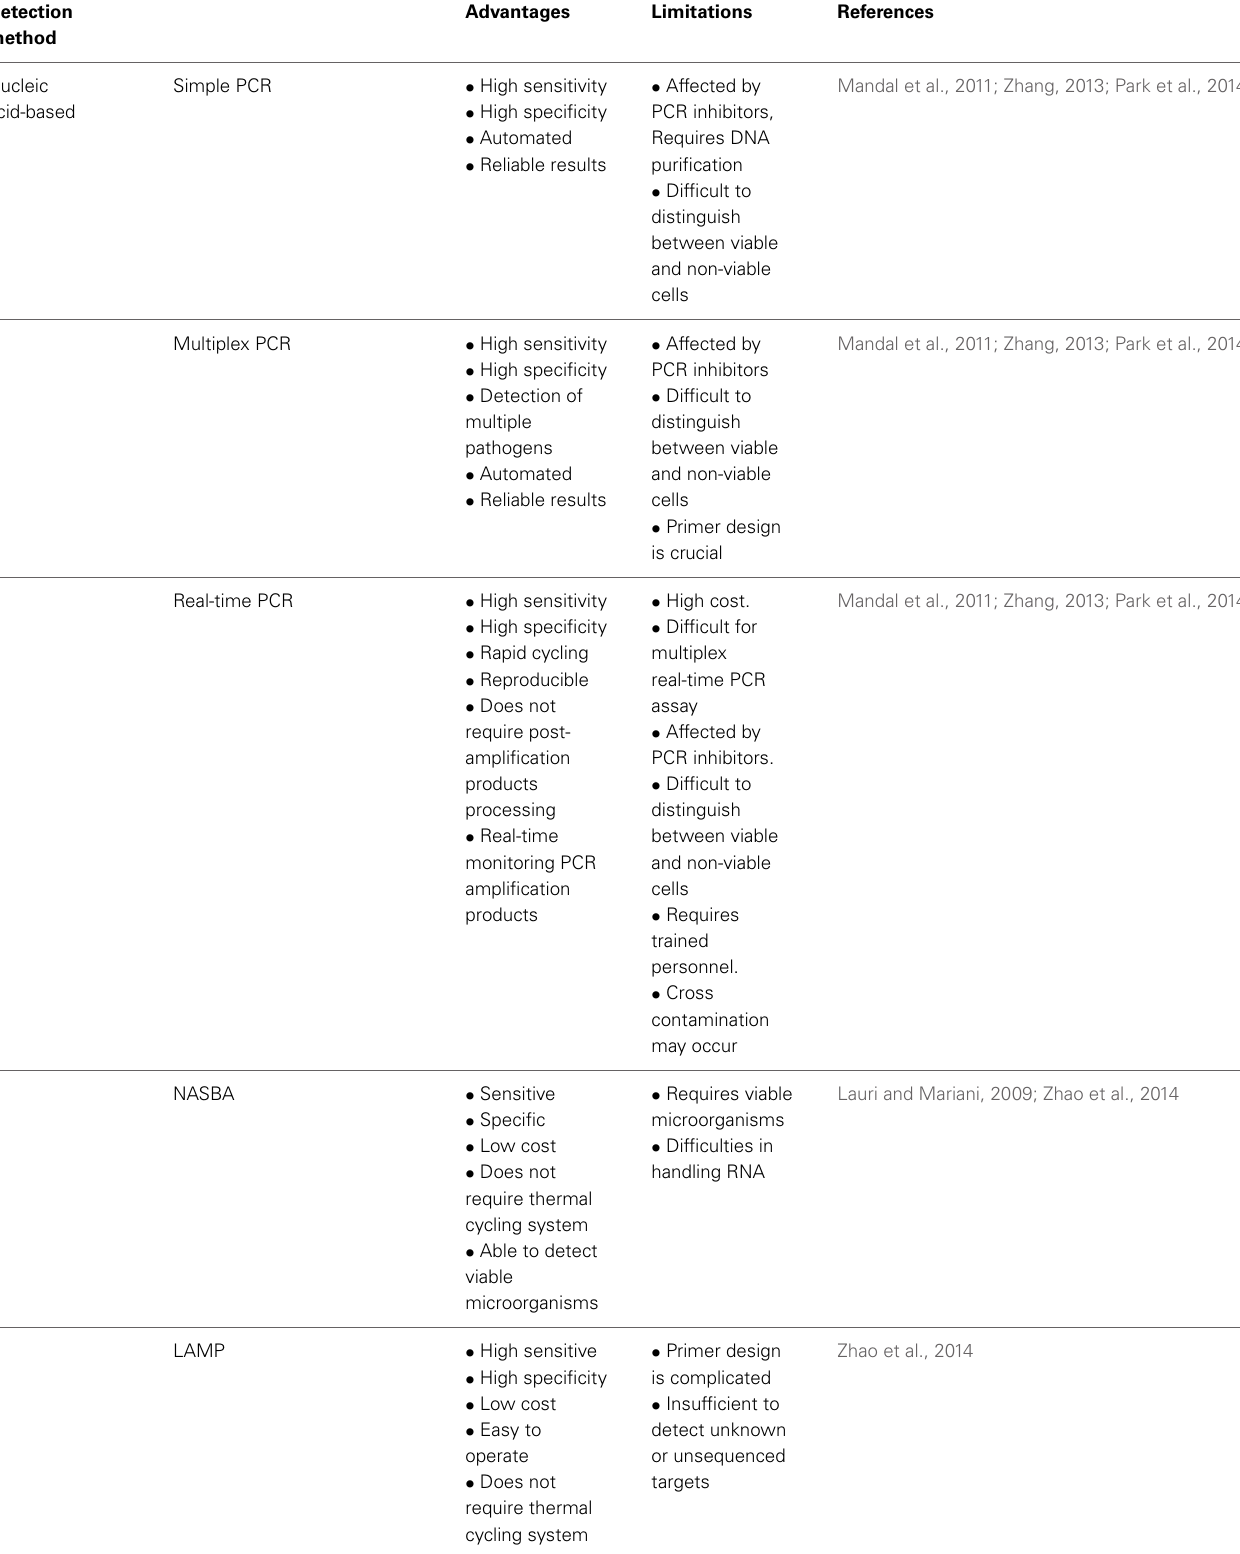
Table 4 | The summary of advantages and limitations of each rapid detection